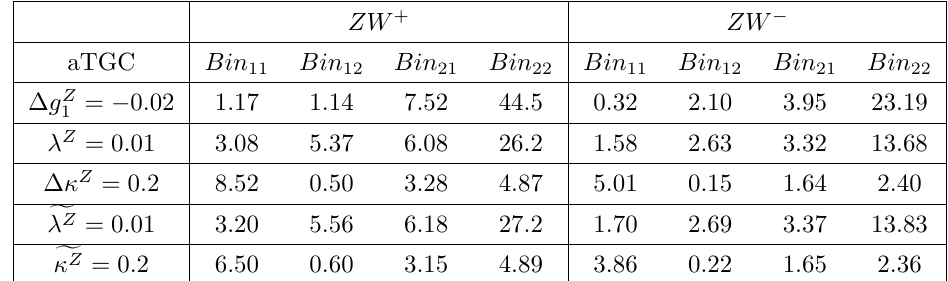
Table 3 . The sensitivities of the cross sections on the (cid:12)ve benchmark aTGC in the four bins (see eq. (2.5)) of m 3 l and p T ( Z ) in the ZW (cid:6) productions at the LHC at p s = 13 TeV and L = 35 fb (cid:0) 1 . 3 Polarization observables of Z and W (cid:6) along with other angular asym-